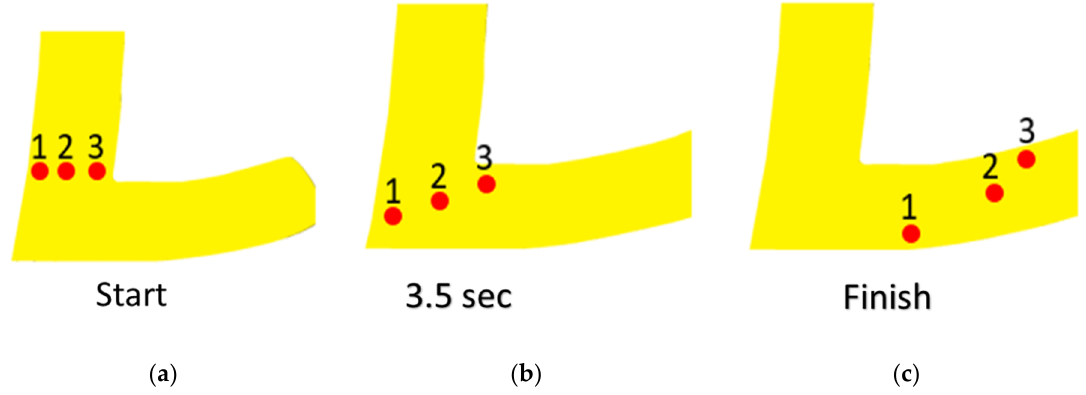
Figure 6. Schematic picture of analysed points for different times of extrusion process: ( a ) start, ( b ) 3.5 second, ( c ) finish.